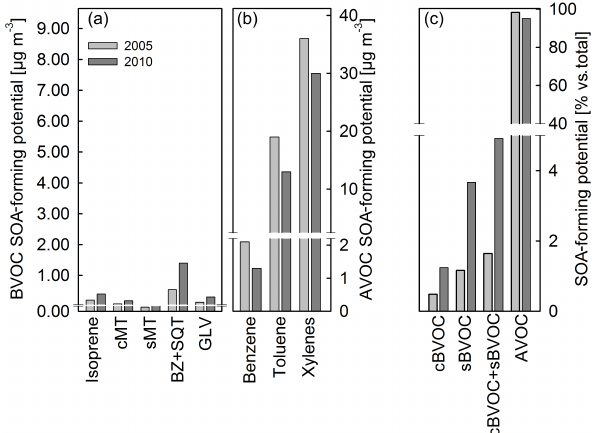
( A ) Phylogenetic tree based on the taxonomic data of the 22 plant species that were analyzed 2 according to iTOL (http://itol.embl.de/). The taxonomic orders/families/species are given only 3 for the main branching points (the complete phylogenetic tree with all internal notes can be 4 found in Supporting Information Table S7). ( B ) Principal component analysis of BVOC 5 emission rates, net assimilation and numerically converted taxonomic data (Table S8, 6 Supporting Information) (left=score plot; right=loading plot). Abbreviations of plant species 7 are given in Table 1. BZ = benzenoids; SQT = sesquiterpenes; GLVs = green leaf volatiles; 8 sMT = stress-induced monoterpenes, cMT = constitutive monoterpenes; IS = isoprene; A = 9 net assimilation. Color code in score plot of panel B reflects panel A. To improve 10 visualization, only the most significant parameters are shown in the loading plot: ( ) net 11 assimilation, ( ) BVOC, ( ) Ginkgoaceae, ( ) Magnoliaceae, ( ) Stem Eudicotyledons, ( ) 12 Asterids, ( ) Oleaceae, ( ) Sapindales, ( ) Saliceae, ( ) Rosales, and ( ) Prunus. R 2 X 13 (Explained X-variation): PC1 = 15.1%, PC2 = 8.6%; significance at 95% confidence). 14